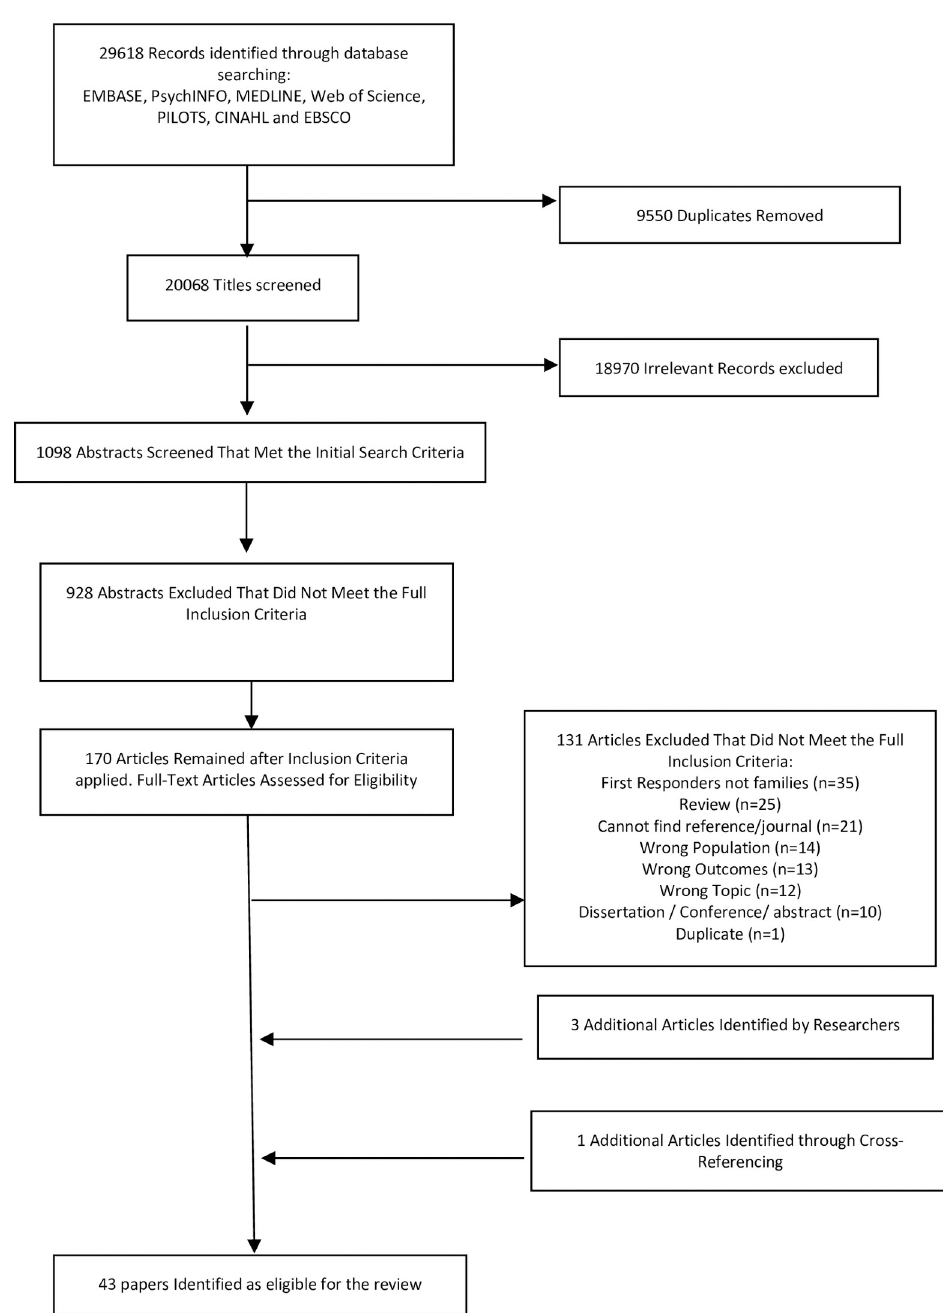
Fig 1. PRISMA flow diagram study selection emergency responder families